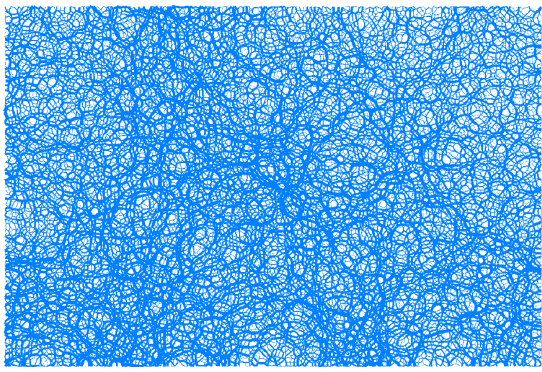
Figure 21. Regional force chain.